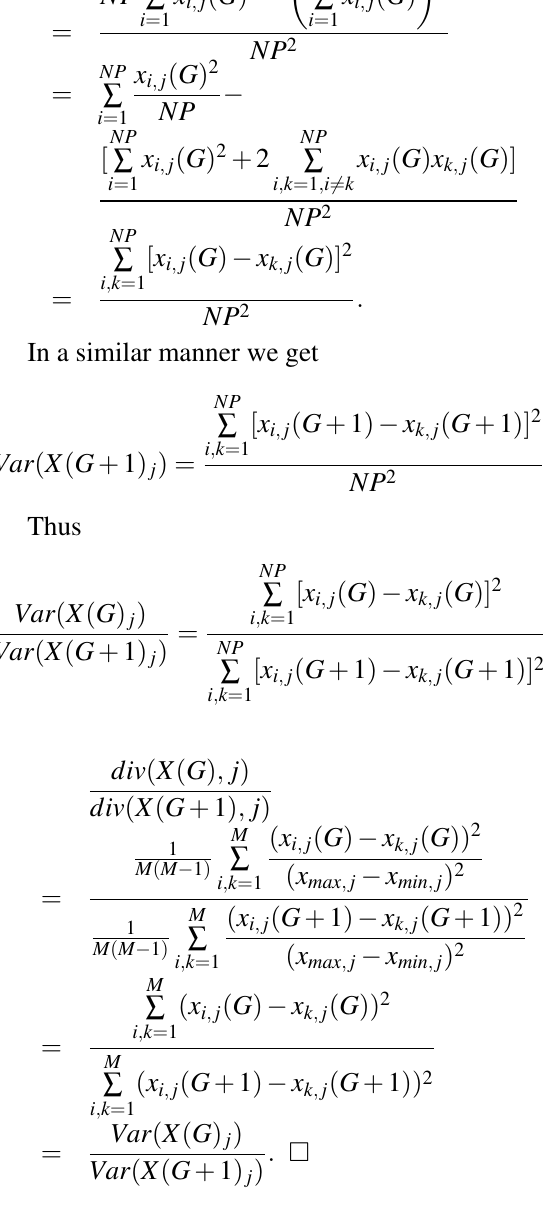
Table 1. The proposed DE algorithm with diversity guided adaptive parameters